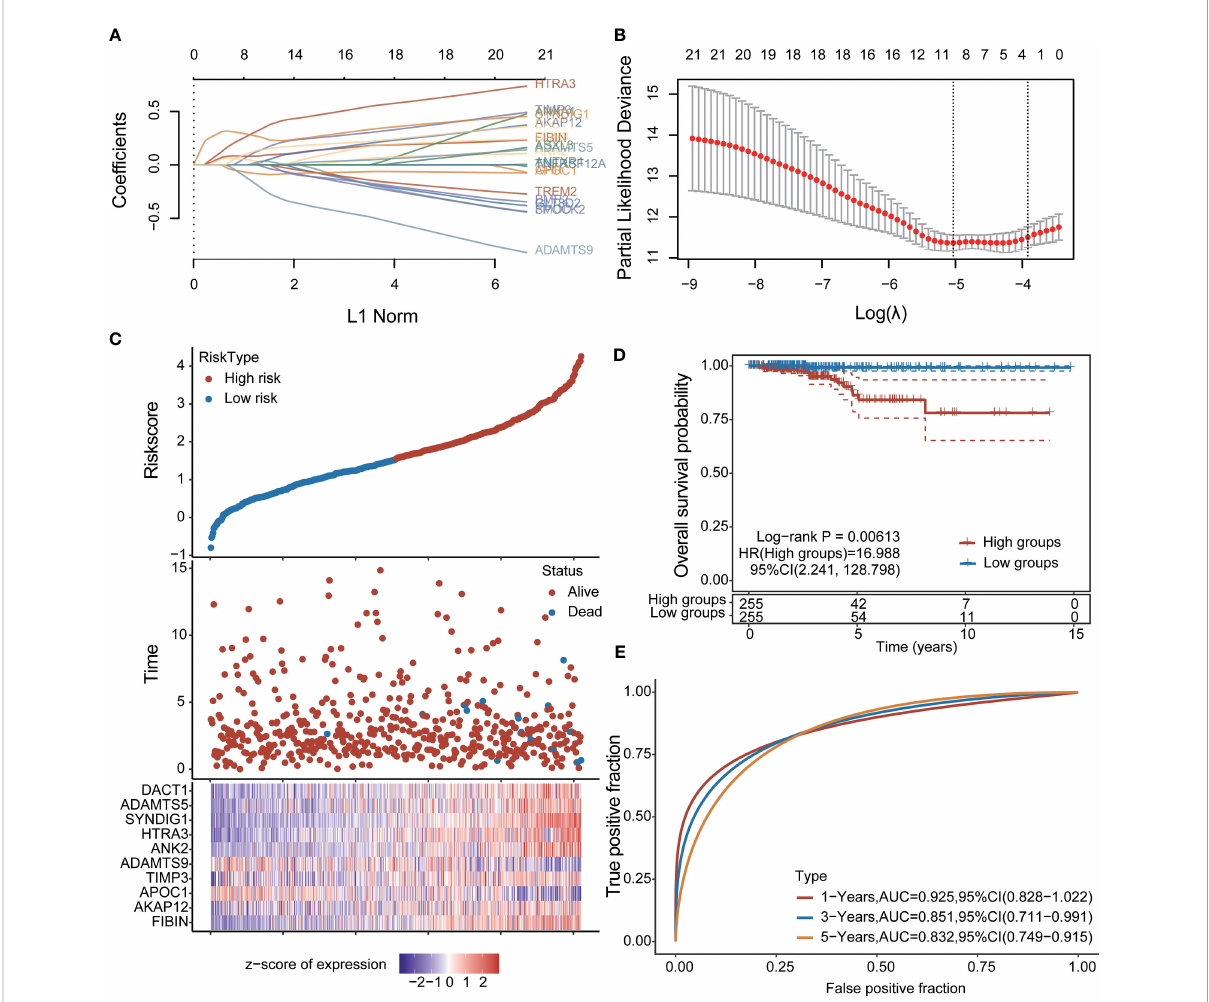
FIGURE 2 Construction of prognostic features of immune-related genes in thyroid cancer (A, B) distribution of LASSO coef fi cients of 21 pivot genes, the adjustment parameter l .min= 0.0065 is obtained, and the vertical black dotted line in B de fi nes the optimal l value; (C) Thyroid cancer Risk score (Riskscore) distribution of patients, survival status and duration of thyroid cancer patients (D) KM survival curves of high and low-risk groups; (E) : ROC curves of 1 year, 3 years and 5